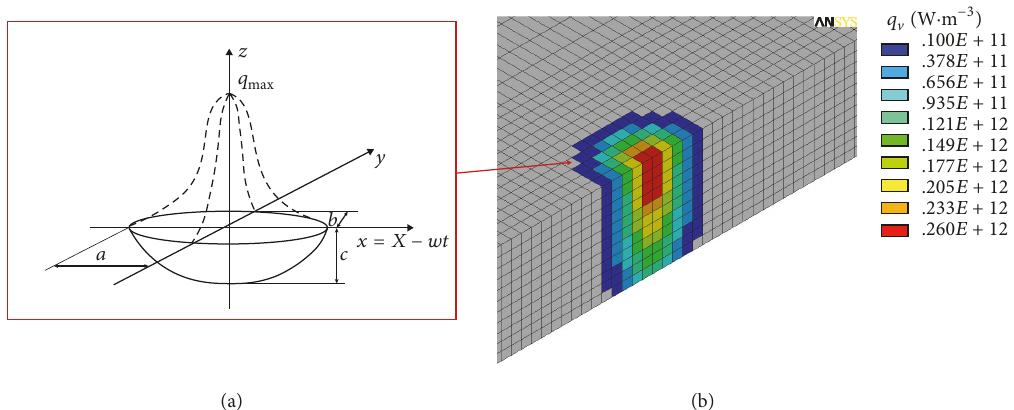
Figure 5: Gaussian ellipsoidal volumetric heat source: (a) the scheme with definition of parameters and (b) application of volumetric heat source to the FE model.